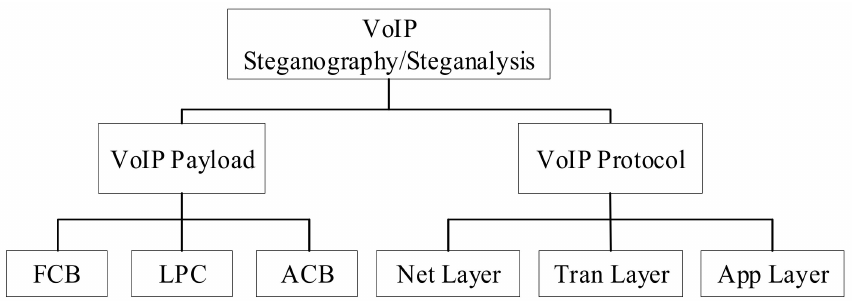
Figure 3. Classification of steganography and steganalysis based on VoIP. For the VoIP-based steganography methods, three indicators of imperceptibility, hid- den capacity, and robustness are applied to evaluate the capability of the